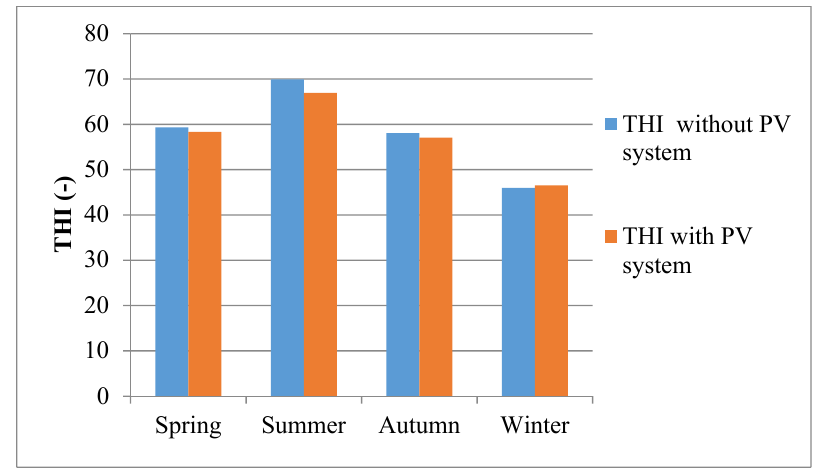
Figure 18. The influence of PV modules installation on the THI values during the year.